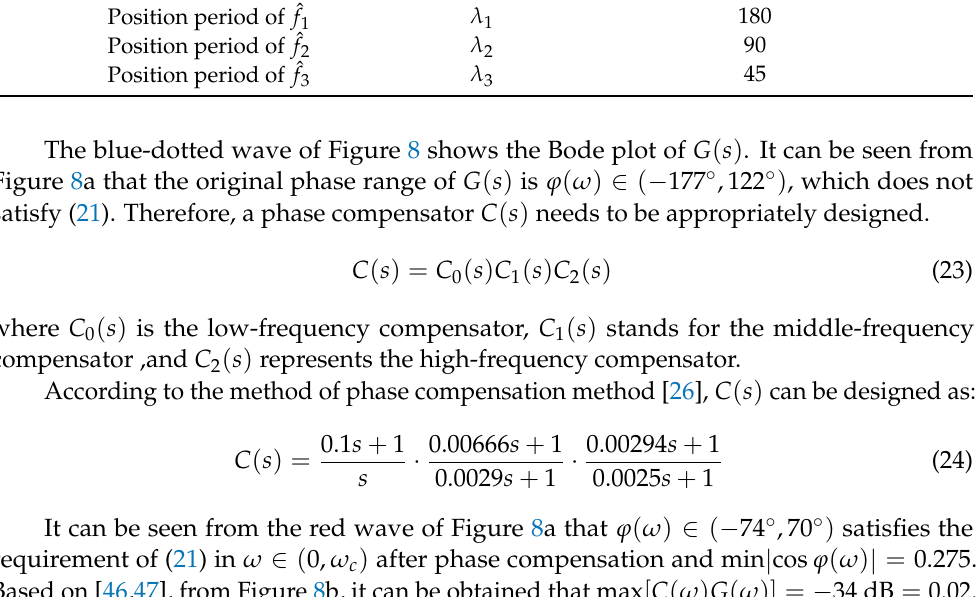
Table 3. Parameters of the gimbal system based on an harmonic drive. Parameter Symbol Value Load moment of inertia J l 0.278 kg · m 2 Load damping B l 0.8 N · m/ ( rad/s ) Motor moment of inertia J m 0.0011 kg · m 2 Motor damping B m 0.02 N · m/ ( rad/s ) Torsional stiffness of harmonic drive K e 3 × 10 4 N · m/rad Torsional moment coefficient K m 0.65 Gear ratio Inductance Back EMF coefficient of motor Gain coefficient of the RC k rc 1.4 Position period of ˆ f 1 Position period of ˆ f